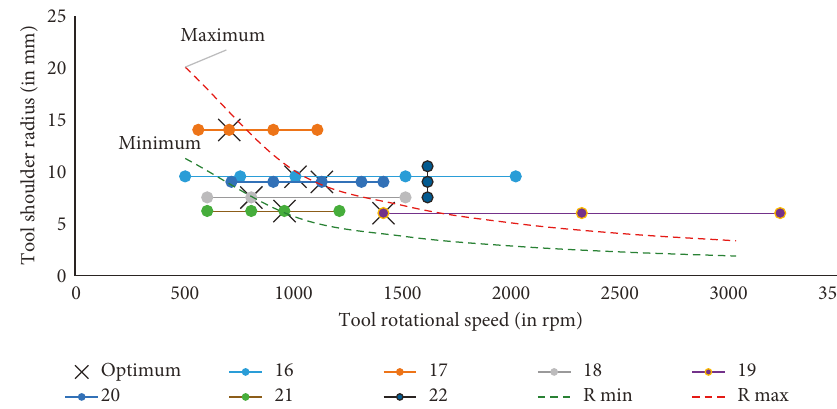
Figure 2: Optimum shoulder radius obtained through different experiments. Table 1: Properties of base metal (AA2024-T3).